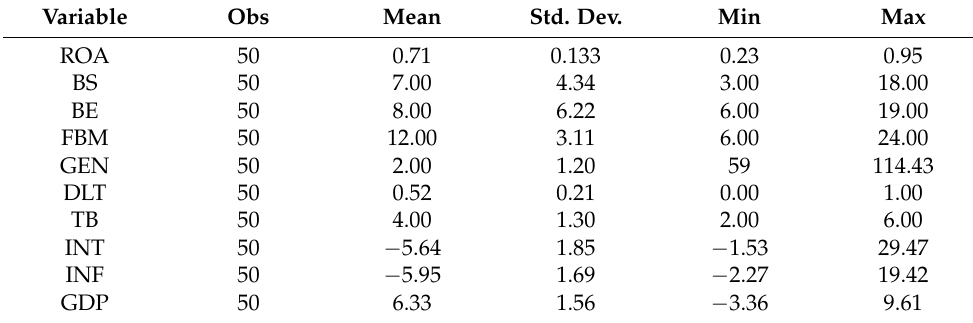
Table 3. Summary